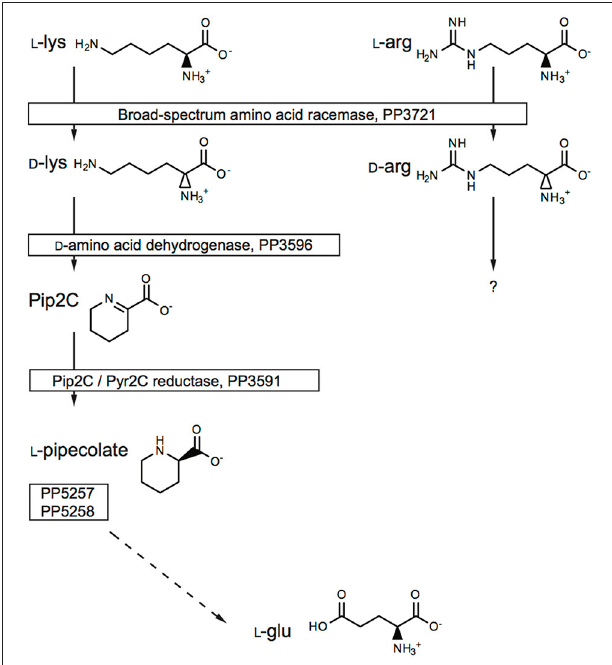
FIGURE 3 | The role of the Alr BSAR in L -Lys and L -Arg catabolism. The gene numbers were obtained from the Pseudomonas Genome Database.